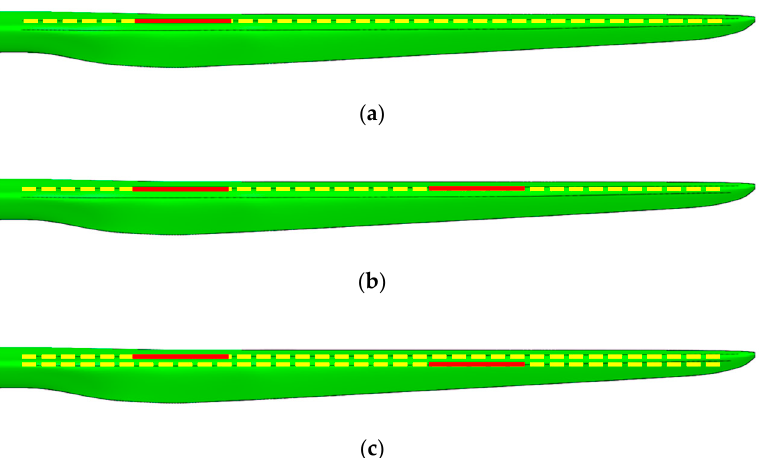
Figure 5. Debonding damage: ( a ) Configuration type 1; ( b ) Configuration type 2; ( c ) Configuration type 3 (shown schematically).